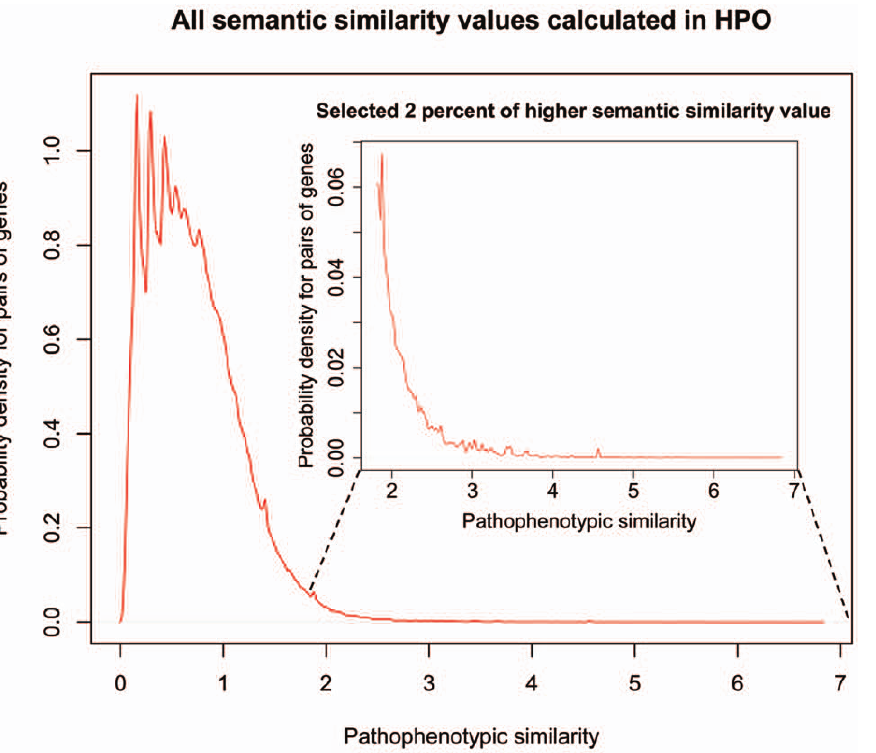
Figure 2. Probability density function for pathophenotypic similarities among pairs of genes in HPO. Densities of the pathophenotypic similarity values for all annotated genes in HPO (outer plot) and for the top 2% of gene pairs with the highest pathophenotypic similarities (inner plot). The bandwidth used was 0.01 and the pathophenotypic similarity value for the cut-off at the top 2% was 1.8179.